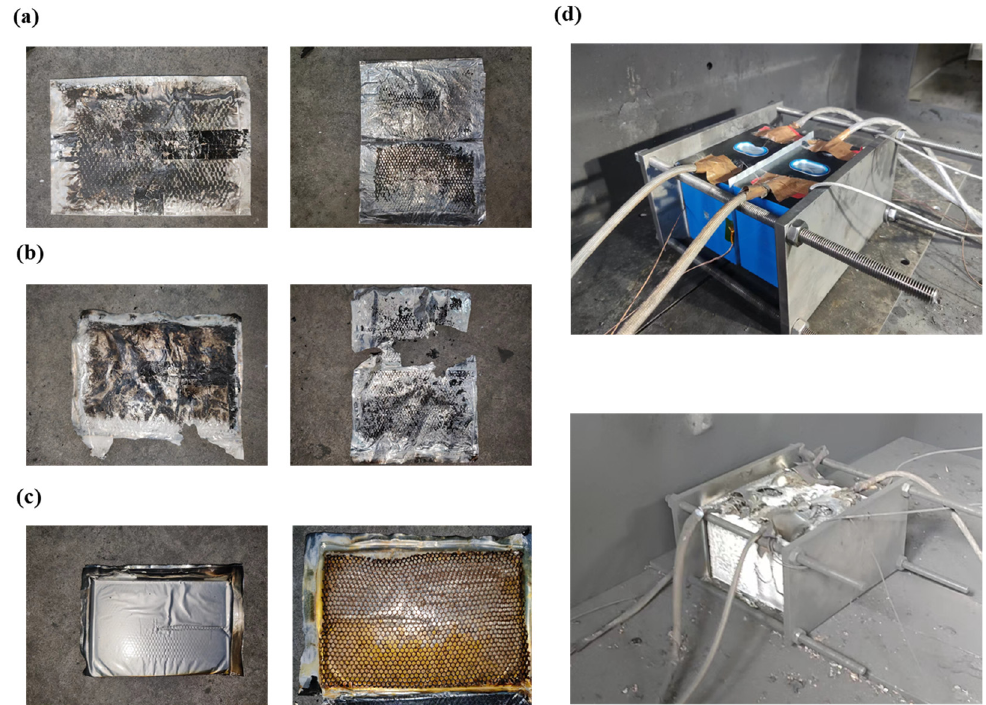
Figure 7. Wreckage after thermal runaway. ( a ) Thermal barrier of test 2; ( b ) thermal barrier of test 3; ( c ) thermal barrier of test 4; and ( d ) battery before and after TRP.